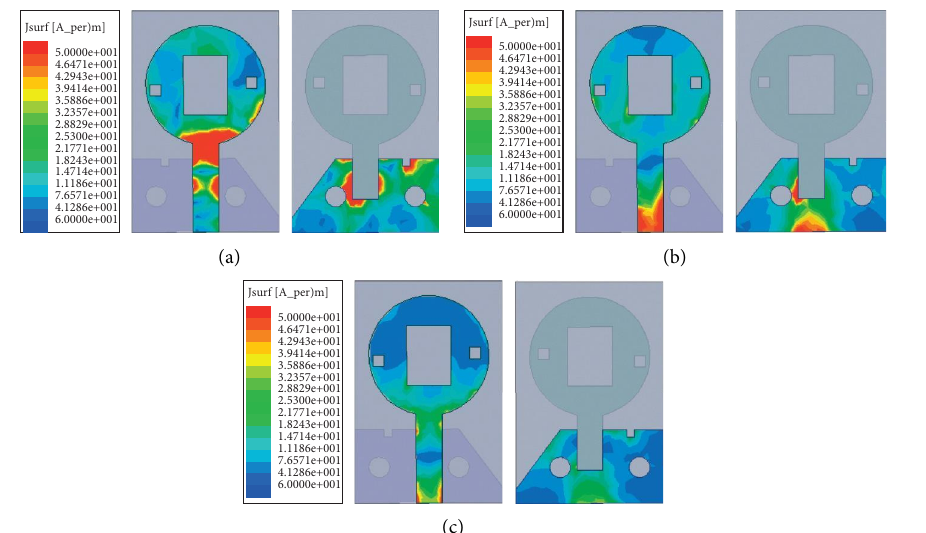
Figure 8: Simulation results of the current distribution of UWB antenna in free space for three different frequency samples: (a) 4 GHz, (b) 6 GHz, and (c) 8 GHz.